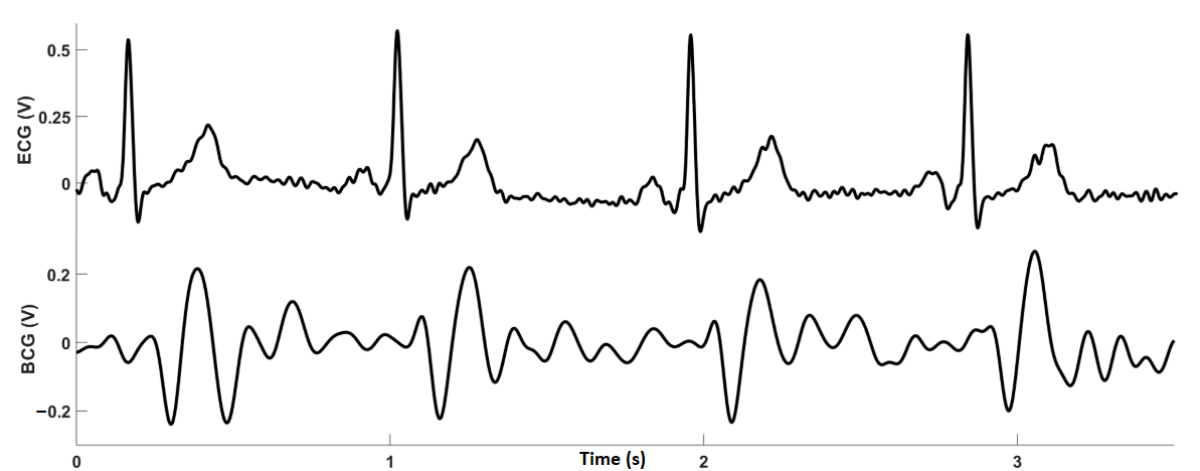
Figure 4. Electrocardiography (top) and ballistocardiography (bottom) recordings obtained simultaneously from a participant. BCG: ballistocardiography; ECG: